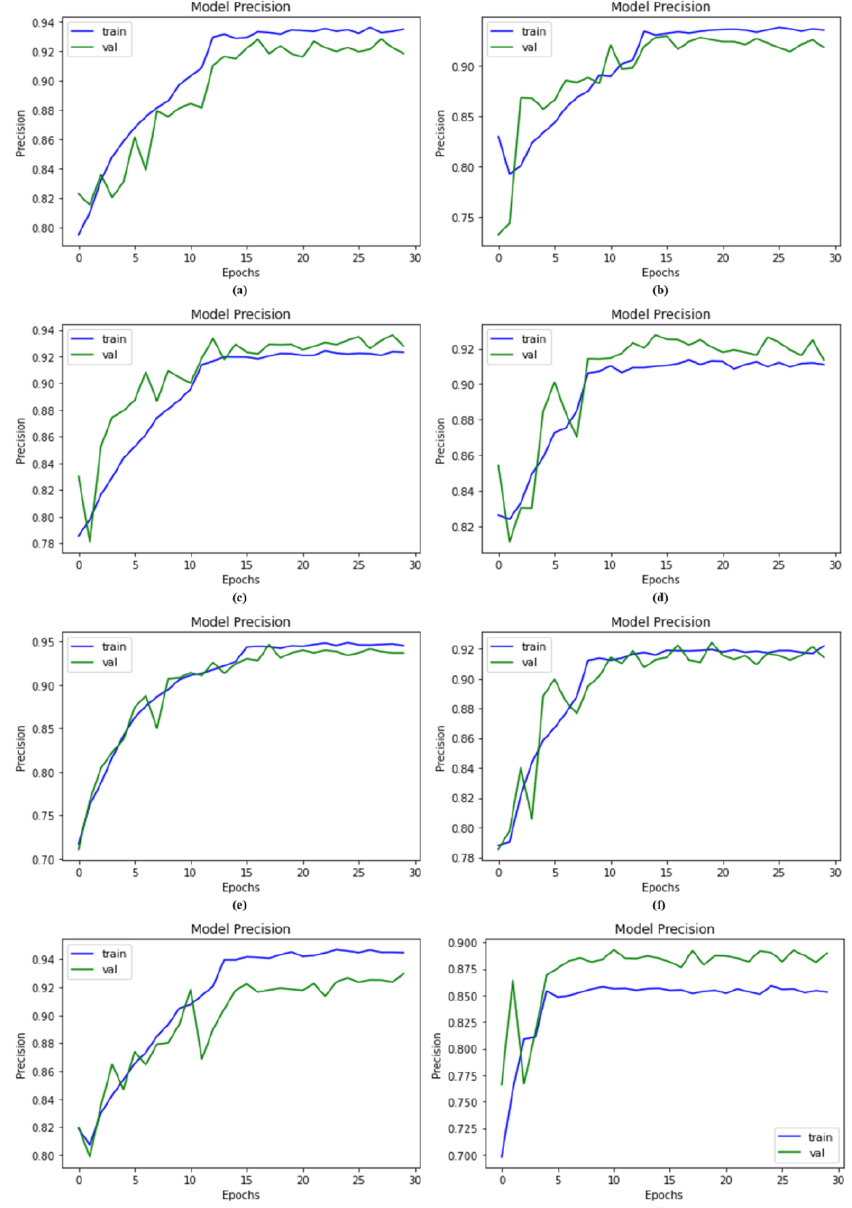
Figure 8. Precision results of the proposed model, DSCC_Net, and other baseline models; ( a ) Vgg-16, ( b ) Vgg-19, ( c ) EfficientNet-B0, ( d ) ResNet-152, ( e ) Inception-V3, ( f ) MobileNet, ( g ) Proposed Model with SMOTE Tomek, and ( h ) Proposed Model without SMOTE Tomek.